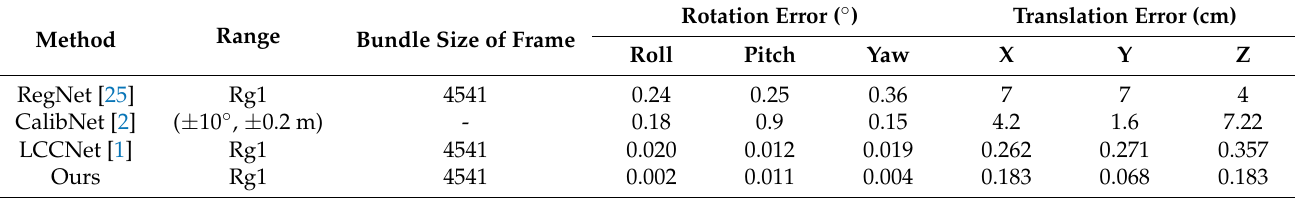
Table 2. Comparison of calibration performance between our method and other CNN-based